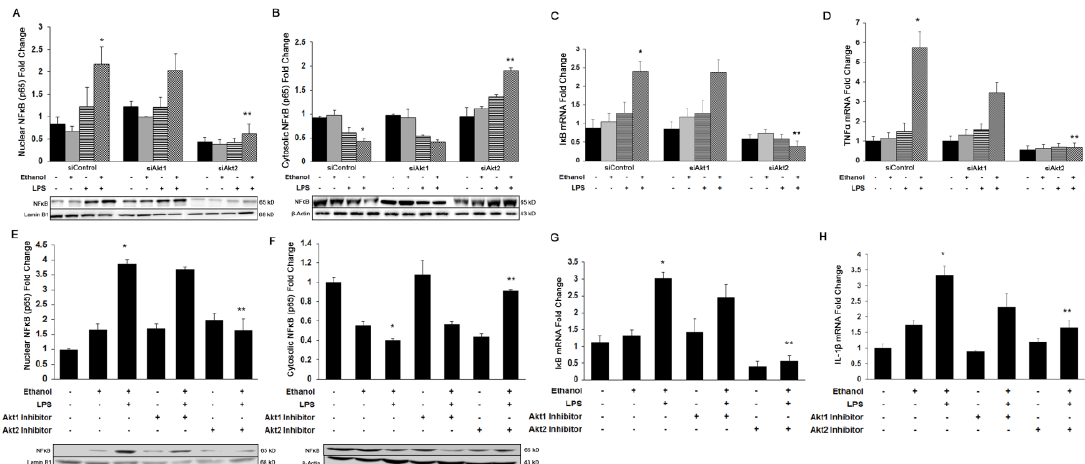
Figure 2. Role of Akt isoforms on ethanol and LPS-induced nuclear translocation of NF κ B-p65 and induction of pro-inflammatory cytokines in vitro and in vivo. Nuclear or cytosolic protein and total RNA was extracted from human Kup ff er cells transfected with siAkt1 or siAkt2 and treated with ethanol, LPS, or both for Western blot analysis of ( A ) nuclear NF κ B-p65, ( B ) cytosolic NF κ B-p65, and qPCR analysis of ( C ) I κ B , and ( D ) Tnf α . Nuclear or cytosolic protein and total RNA was extracted from mouse liver tissue treated with Akt1 or Akt2 inhibitors and treated with EB and EBL ( n = 6) for Western blot analysis of ( E ) nuclear NF κ B-p65, ( F ) cytosolic NF κ B-p65, and qPCR analysis of ( G ) I κ B and ( H ) Il1 β . All values are means of triplicate experiments ± SE after correcting for the expression of Lamin B (nuclear), β -actin (cytosolic), or glyceraldehyde-3-phosphate dehydrogenase ( Gapdh ) (qPCR). * p ≤ 0.05 as compared to control, ** p ≤ 0.05 as compared to ethanol Ethanol, LPS, or both, and / or LPS or EBL.